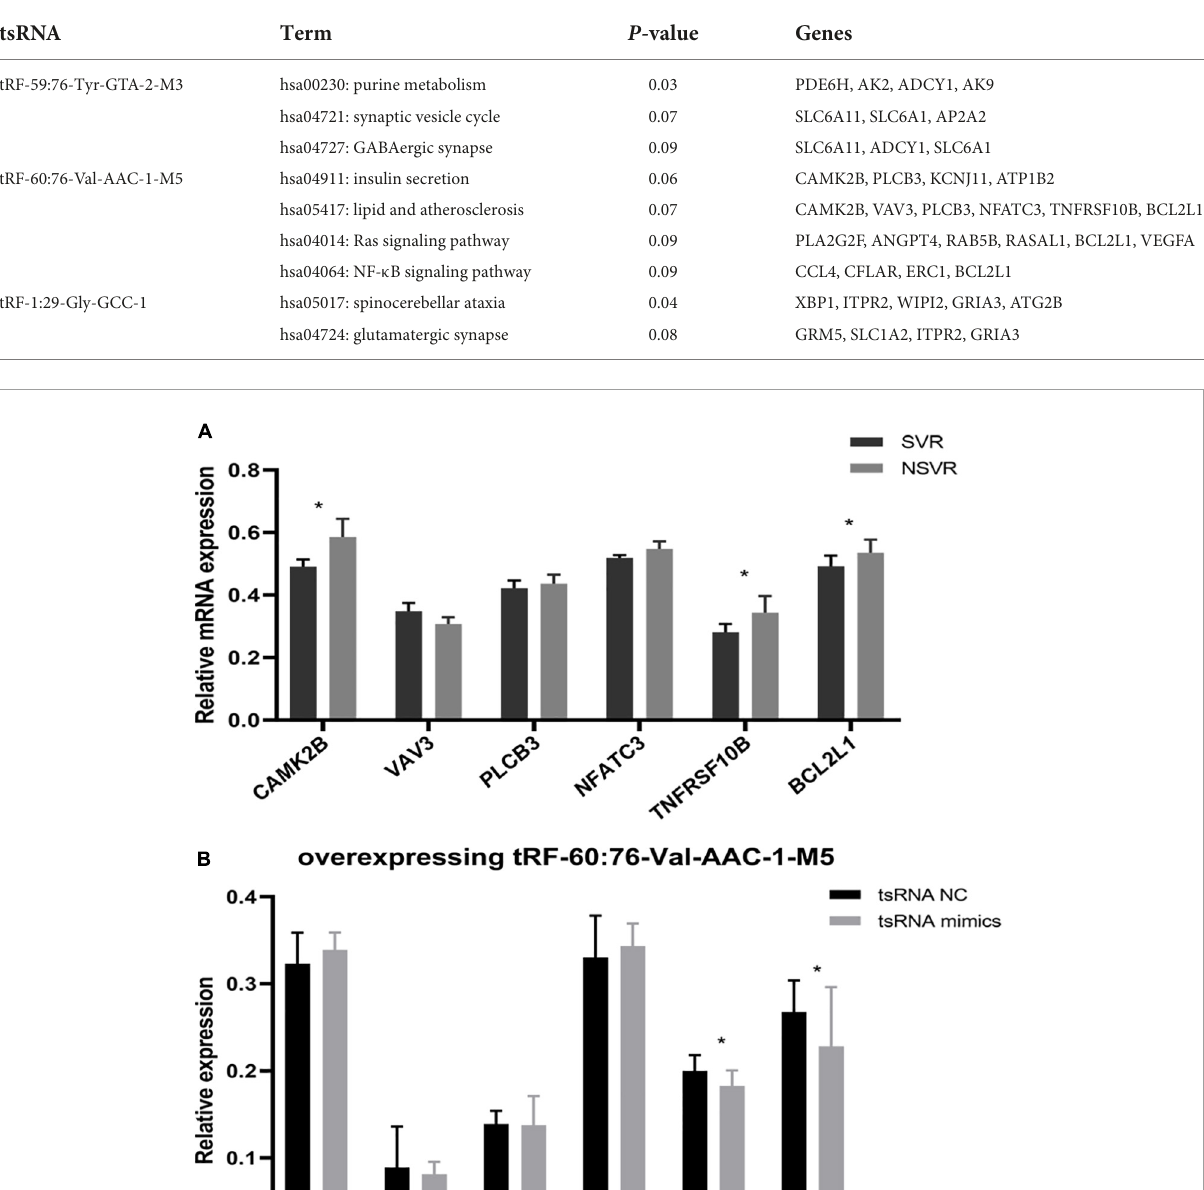
TABLE 5 Kyoto Encyclopedia of Genes and Genomes pathways of the target genes.